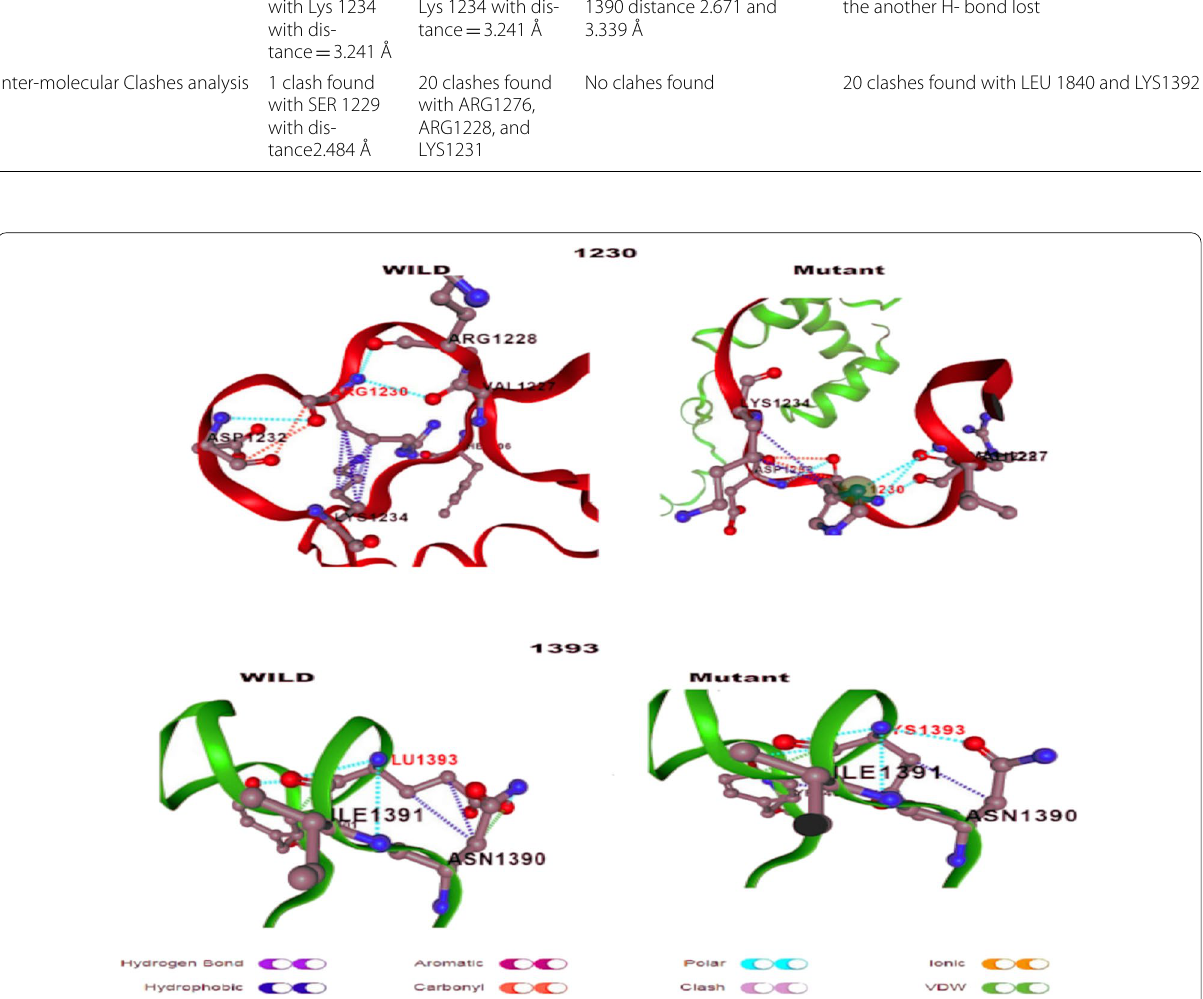
Fig. 7 Intra‑molecular Interactions analysis by using PremPs server: The tow interesting sites 1230 with wild (ARG) and mutant (HIS) intearctions with adjacent residues (VAL 1227, ARG 1228, ASP 1232, PHE 2006 and LYS 1234) and 1393 with wild (GLU) and mutant (LYS) interactions with adjacent residues (ASN 1390 and ILE 1391). Each type of interaction have its specific graphical color and appeared as line